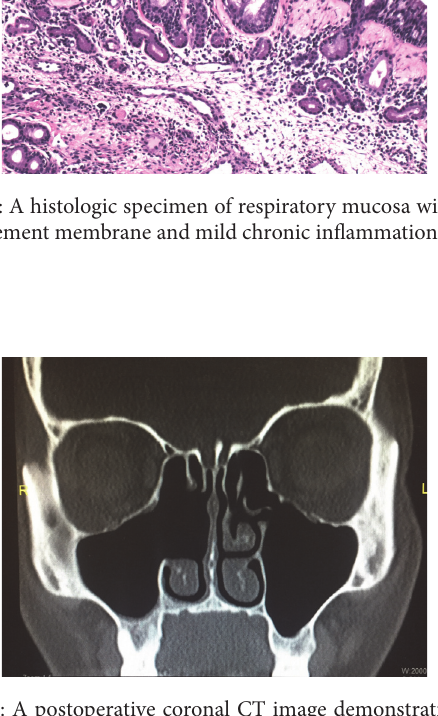
Figure 4: A postoperative coronal CT image demonstrating well- aerated right maxillary and ethmoid sinuses without mucosal thickening with a patent ostiomeatal complex after right maxillary antrostomy, middle turbinectomy, and anterior and posterior eth-